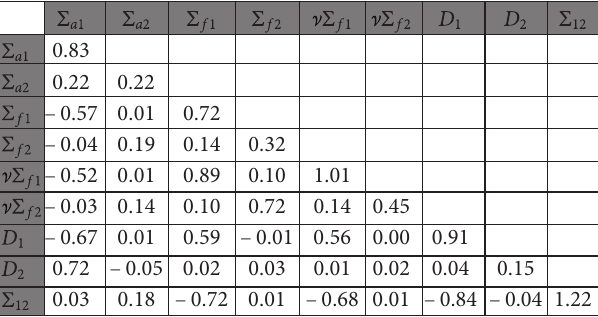
Figure 4: BWR HFP covariance